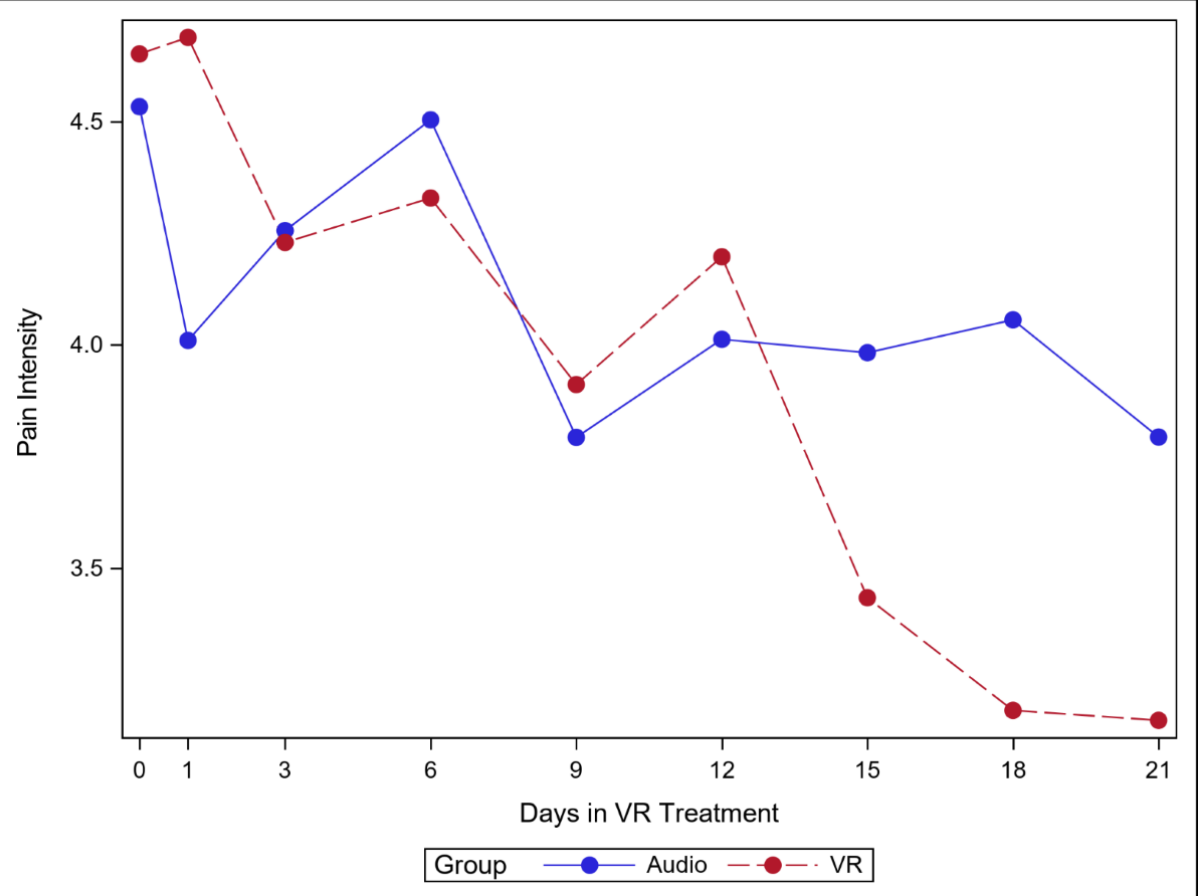
Figure 4. Effect of virtual reality vs audio on pain intensity over